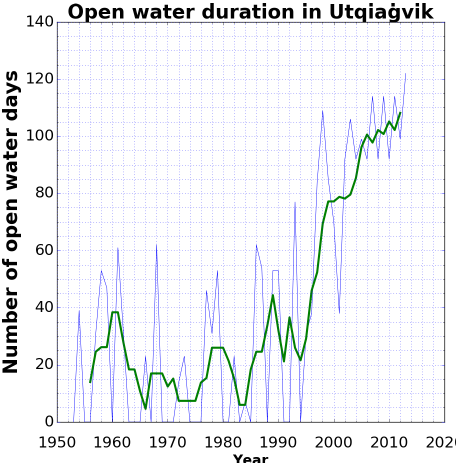
Figure 9. Number of open water days at Utqia˙gvik, AK, has in- creased substantially since the dataset began in 1953. There has been a marked shift such that after 1992, Utqia˙gvik has seen at least some days of open water. Bold green line shows the 5-year running mean of the number of open water days as defined by a 30% sea ice concentration threshold. Data are from